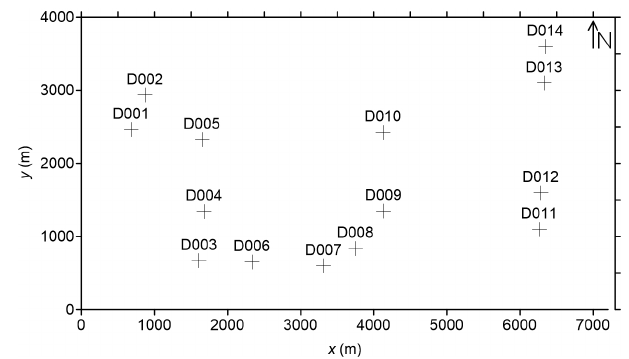
Figure 1. The relative positions and numbers of leveling points.